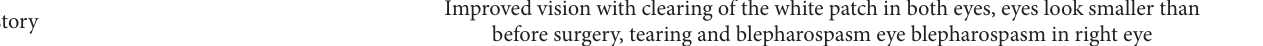
Table 5: Examination under anesthesia six weeks after delayed suprachoroidal hemorrhage drainage.